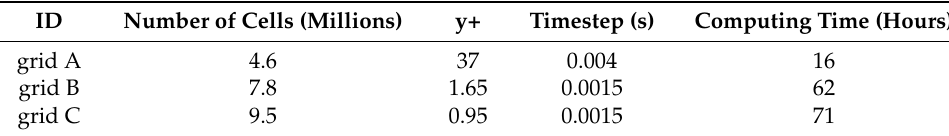
Table 1. Computational grid specifications and numerical